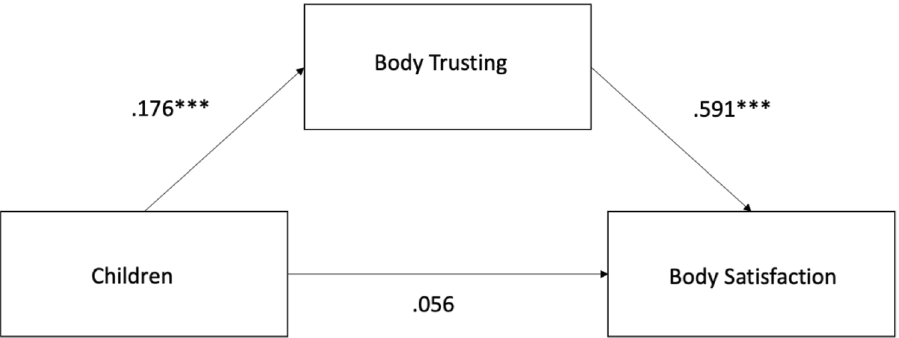
Figure 2. Mediation effect of body trusting on the relationship between having children and body satisfaction. Body trusting was found to be a significant mediator, such that differences in body satisfaction between those with and without children are mediated by changes in body